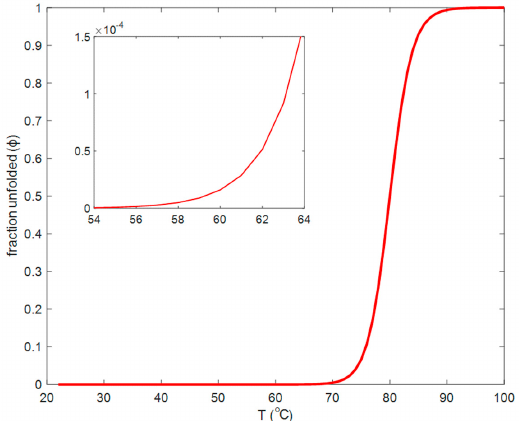
Figure 11. Fraction of unfolded lysozyme as a function of temperature.